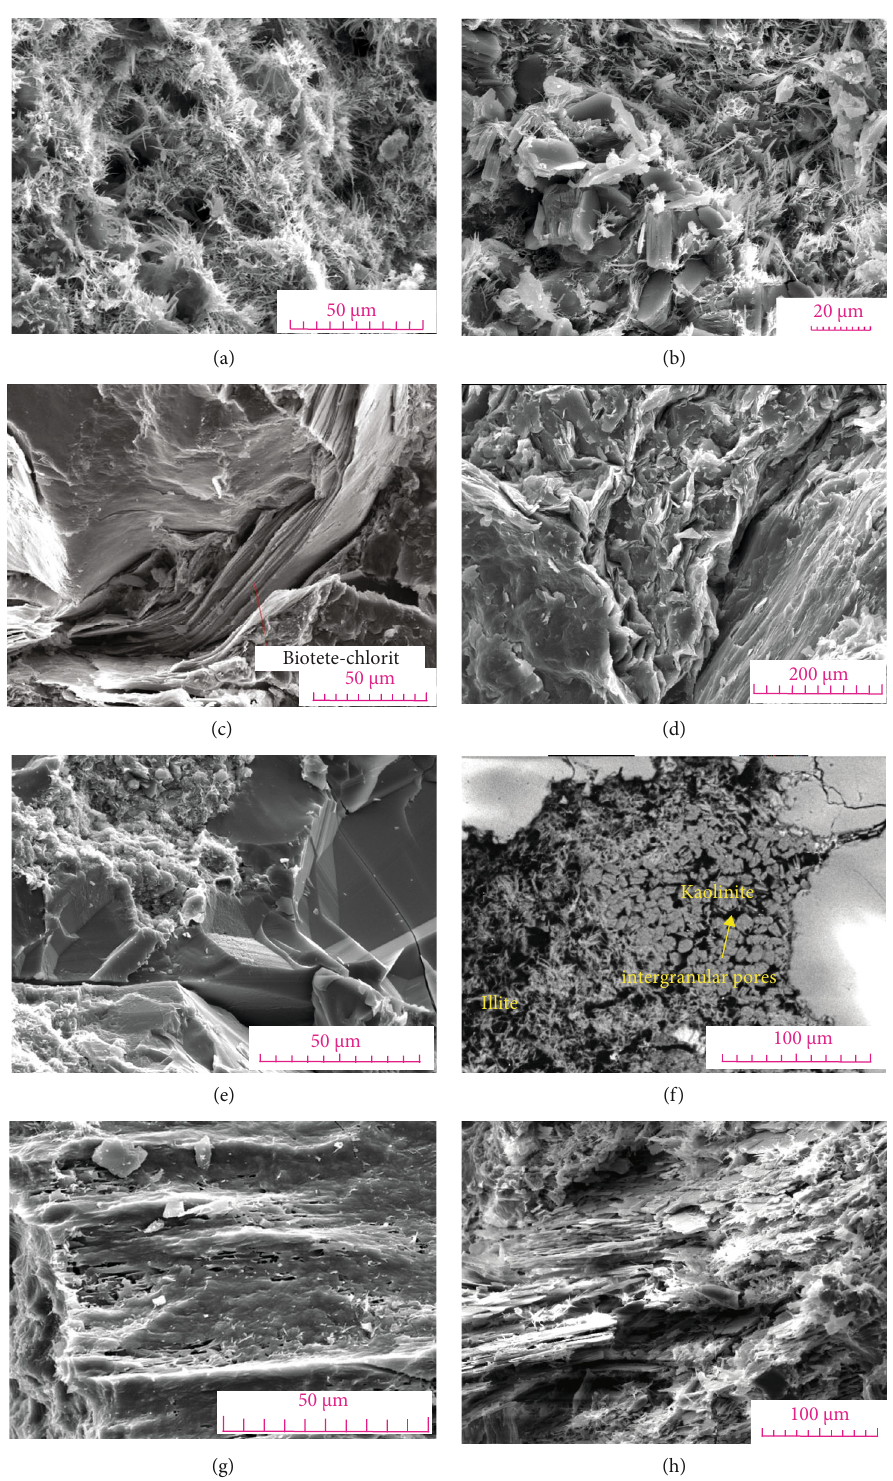
Figure 4: Scanning electron microscope photomicrographs showing pore space and morphology of minerals fi lled in space in the Ahe Formation of Dibei area. (a) Yn2, J y, 4538.31m: intergranular fi brous illite and smectite mixed layers. (b) Yn5, J 1 y, 4562.8m: pores and fi ssures between lamella biotite and chlorite minerals. (d) in book-like form and illite in hair-like form. (c) Yn5, J 1 Yn5, J y, 4562.8m: long-narrow fi ssures between grains. (e) Yn, J a, 4851.8m: intercrystalline pores between secondary quartz crystals. (f 1 1 ) Ys4, J1a, 3981.6m: kaolinite and illite fi lling between grains in thin sections under SEM. (g) Yn5, J micropores in feldspar are developed along joint seams. (h) Yn5, J a, 4775.23m: fl at fi ssures are formed by corrosion along joint seams 1 in